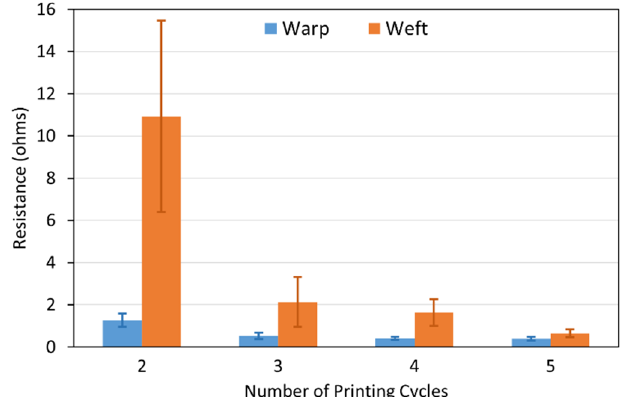
Figure 6. Electrical resistance of the metallised patterns printed with the Cu–Ag NP catalyst at different numbers of cycles and directions.